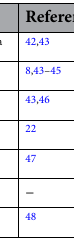
Table 2. Initiating transferase sugar specificities. a R is either Acetyl (Ac) or (S)-3-hydroxybutanoyl. b ItrB2 is